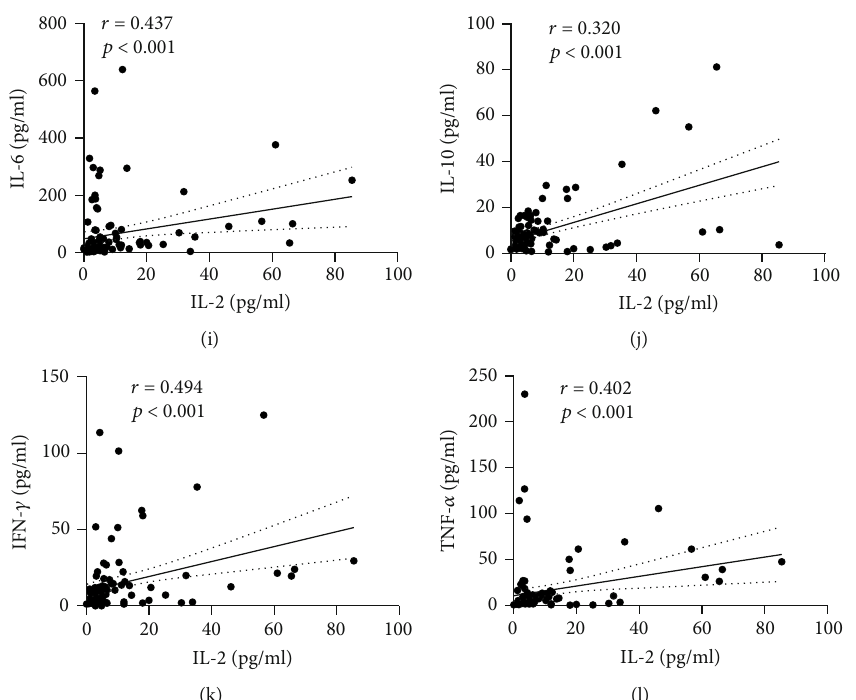
Figure 3: Correlation analysis between serum IL-2 level of RA patients and various clinical indicators. (a – c) Correlation analysis between serum IL-2 level of RA patients and DAS28, ESR, and VAS. (d) Correlation analysis between serum IL-2 level of RA patients and serum RF level (only 61 patients with RA had autoantibodies test results). (e, f) Correlation analysis between serum IL-2 level of RA patients and NK cell number and percentage of NK cells. (g) Correlation analysis between serum IL-2 level of RA patients and Th17/Treg ratio. (h – l) Correlation analysis between serum IL-2 level of RA patients and IL-4, IL-6, IL-10, INF- γ , and TNF- α . Shown are linear regression lines with interpolated 95% con fi dence interval curves (broken lines).